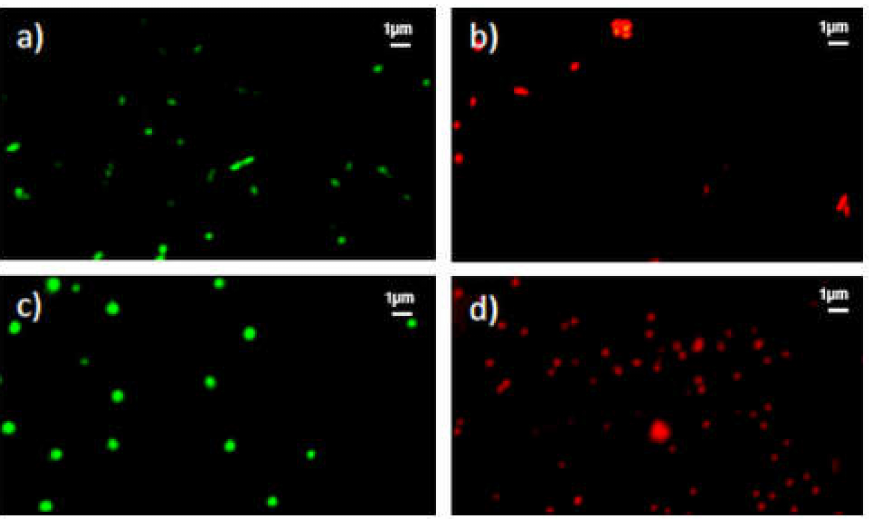
Figure 2. Live/dead assay. ( a ) E. coli control plate, ( b ) E. coli 8C7 modified plate, ( c ) S. epidermidis con- trol plate, and ( d ) S. epidermidis 8C7 modified plate; Reproduced with permission from El Habnouni, S.; Lavigne, J.P.; Darcos, V.; Porsio, B.; Garric, X.; Coudane, J.; Nottelet, B., Acta Biomater. 2013